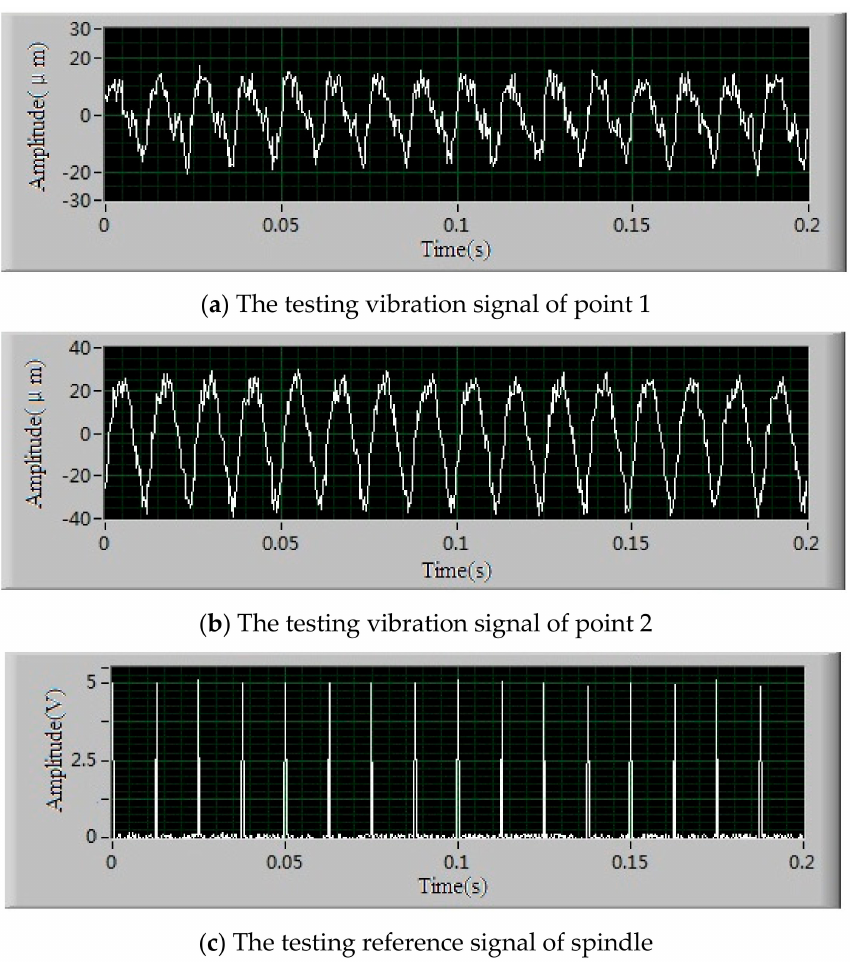
Figure 9. The original vibration signals and reference signal of the